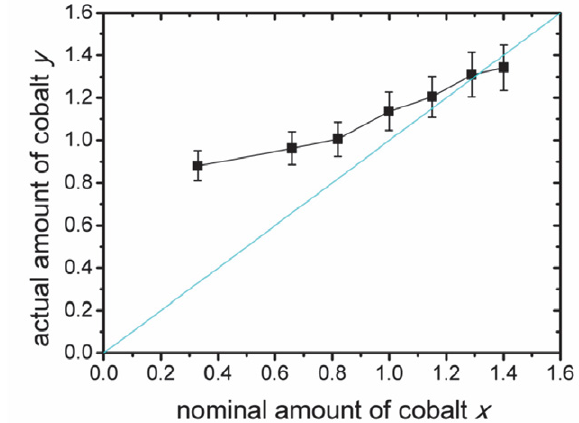
Figure 4. The actual amount of cobalt y in ferrite Co y Fe 3-y O 4 versus the nominal amount of cobalt x.